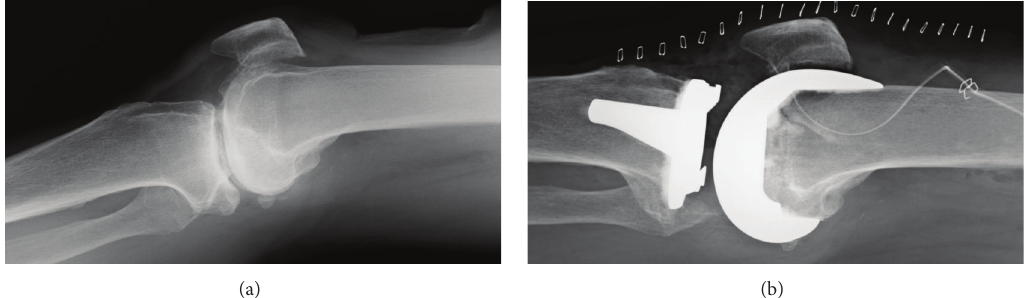
Figure 3: Lateral radiographs of the knee. (a) Preoperative passive knee extension without anesthesia. (b) Passive extension under postoperative anesthesia immediately postoperatively. Full knee extension was restricted preoperatively but it was possible immediately postoperatively.